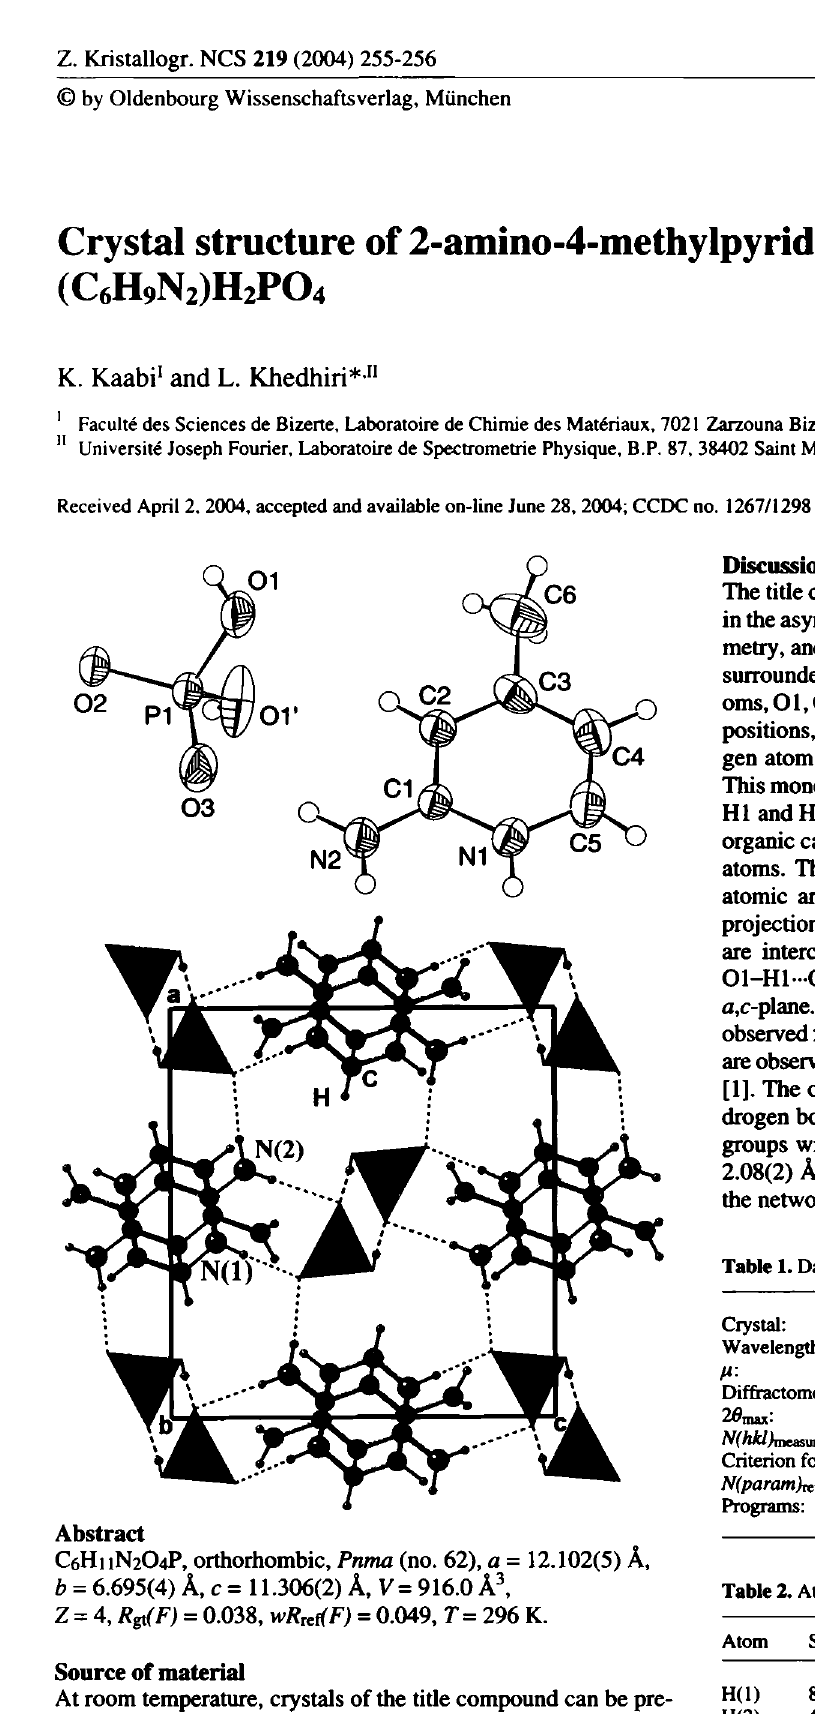
Table 2. Atomic coordinates and displacement parameters (in Â 2